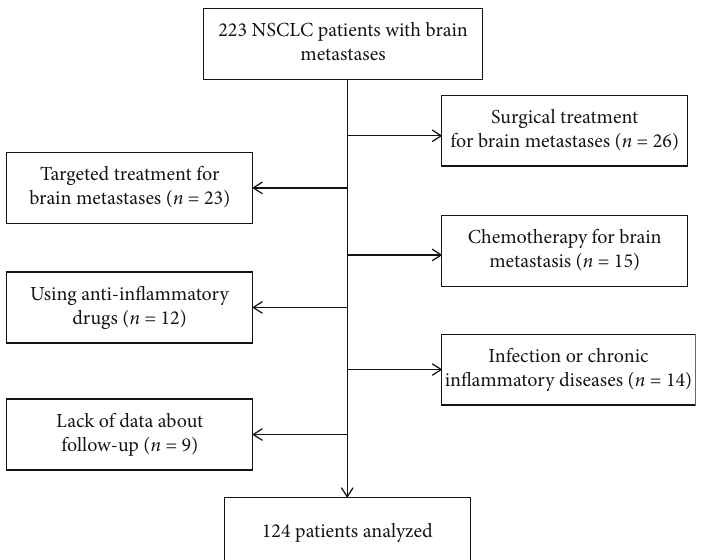
Figure 1: Selection of patients for this study.